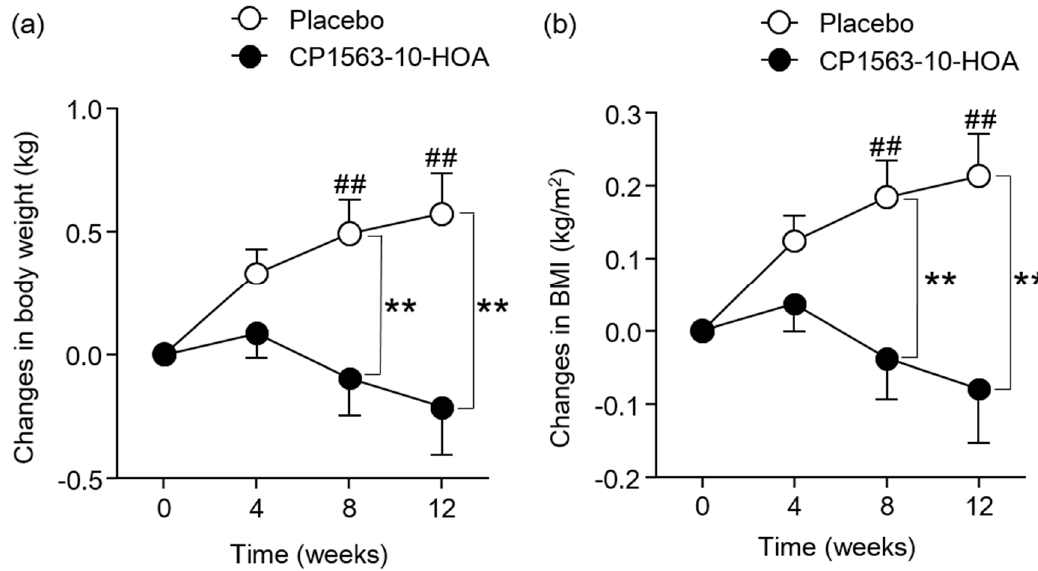
Figure 3. Changes in anthropometric parameters. Changes in body weight ( a ) and changes in BMI ( b ). Data are shown as the mean ± SEM (the CP1563-10-HOA group: n = 85, the placebo group: n = 84). ** p < 0.01. vs. placebo group (by Student’s t -test.). ## p < 0.01. vs. 0 weeks (by Dunnett’s test).